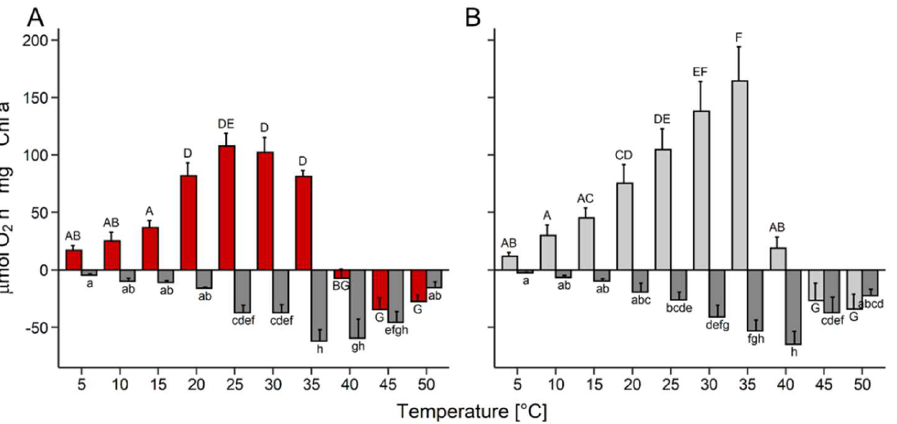
Figure 2. Effects of temperature on photosynthesis and respiration. Gross photosynthetic oxygen production and respiratory oxygen consumption were measured at 200 μmol photons m –2 s –1 as a function of increasing temperature in ( A ) Diplosphaera epiphytica and ( B ) Edaphochlorella mirabilis . Red and light grey bars show gross photosynthetic oxygen production in ( A ) and ( B ), respectively, and dark grey bars show respiratory oxygen consumption in both panels; data are means ± SD ( n = 4). Different small (respiratory oxygen consumption) and capital (gross photosynthesis) letters indicate significant differences between temperature treatments and species, and were calculated by two-way ANOVA followed by Tukey’s post hoc test ( p < 0.05).